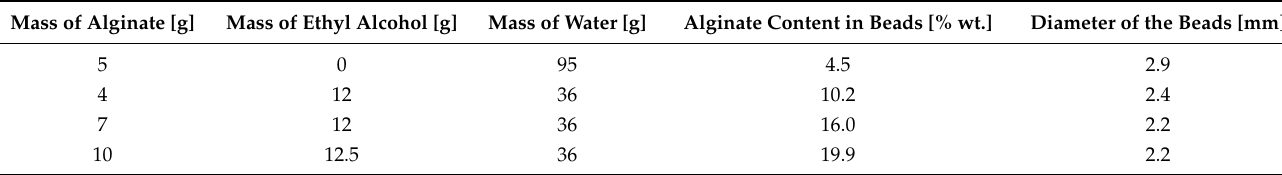
Table 2. Characteristics of the obtained alginate